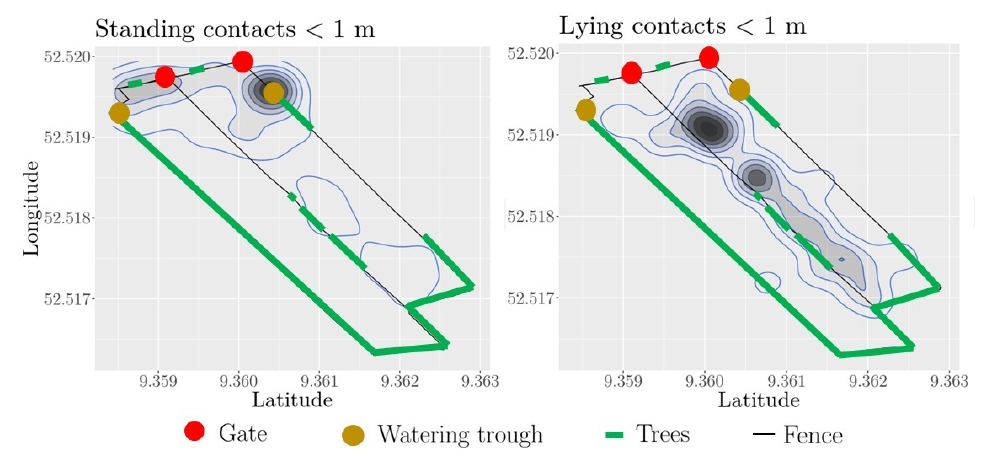
Figure 5. Contact zones of standing and lying heifers, respectively. The dark zones mark the areas of a high number of pairwise contacts, i.e., the distance between heifers is less than the distance threshold of 1 m. The distribution of contacts is shown by blue lines. Black thin lines indicate the fence of the pasture; the middle fence separates the eastern from the western part. The gate (red) at the middle fence is open, and the heifers can move freely between the eastern and western pasture part.